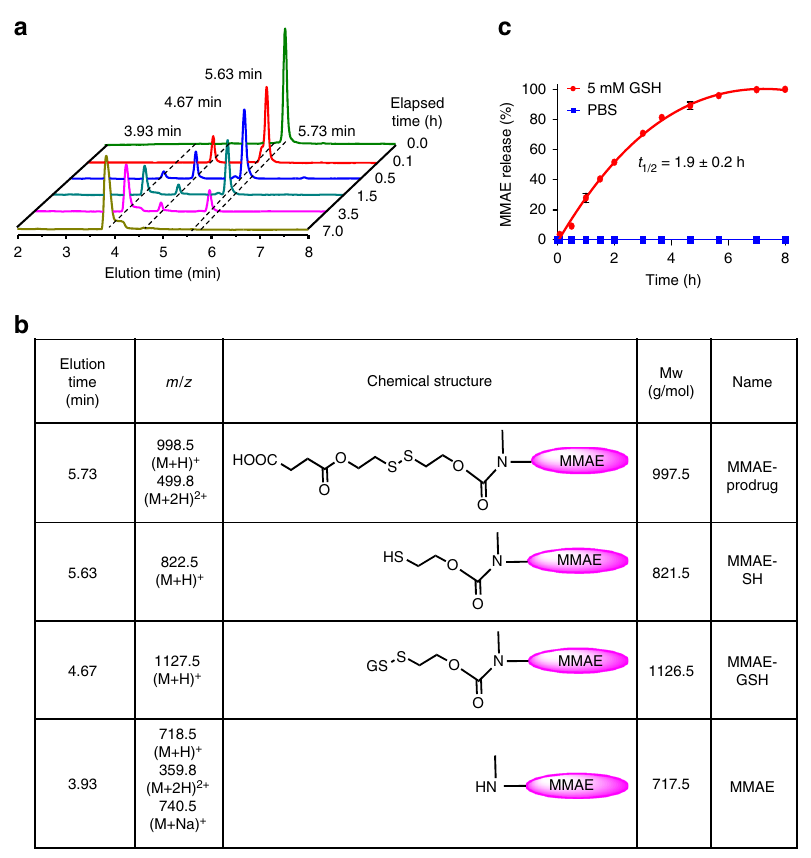
Fig. 2 In situ kinetics for release for MMAE from the reductive-sensitive linker. a UV – Vis detection of different elution bands corresponding to the products formed from the reaction of the MMAE-bound and reductive-sensitive linker with 5 mM glutathione (GSH) as determined by LC – MS. b Retention times, mass-to-charge ratios ( m / z ), chemical structures, and the calculated masses of the isolated products from each of the different elution bands corresponding to the traces in a . c Rates of release of MMAE from the reductive-sensitive linker in phosphate saline buffer (PBS; pH 7.4, 37 °C; blue) and after the addition of GSH (5 mM; the calculated molecular weights of the compounds (Fig. 2b and Supplementary Fig. 11). By plotting the changes in the values for the absorption peak corresponding to the MMAE- prodrug ( t = 5.73 min) vs. the elapsed time after GSH addition, the rate of free MMAE release from the linker was obtained (Fig. 2c, red). The results demonstrate that the MMAE-prodrug is completely converted to free MMAE under high reducing conditions, exhibiting a transformation half-life of 1.9 ± 0.2 h.